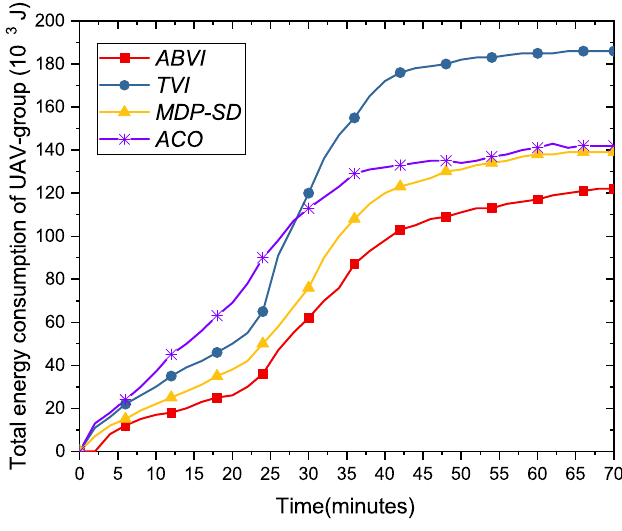
Figure 4. The total energy consumption of the UAV group versus